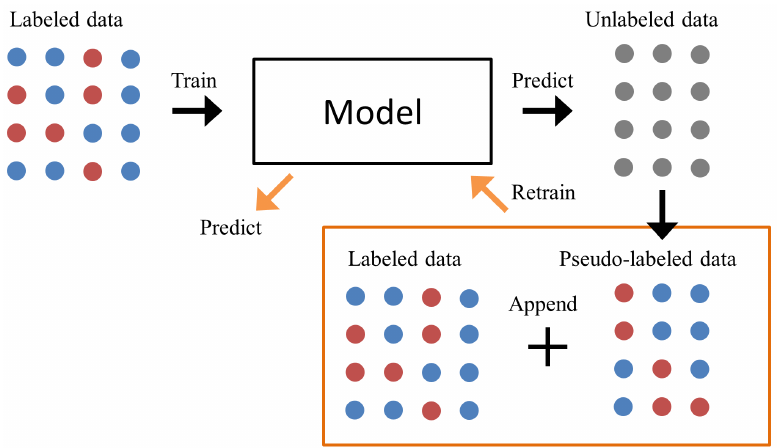
Figure 2. Schematic diagram of pseudo-labeling.